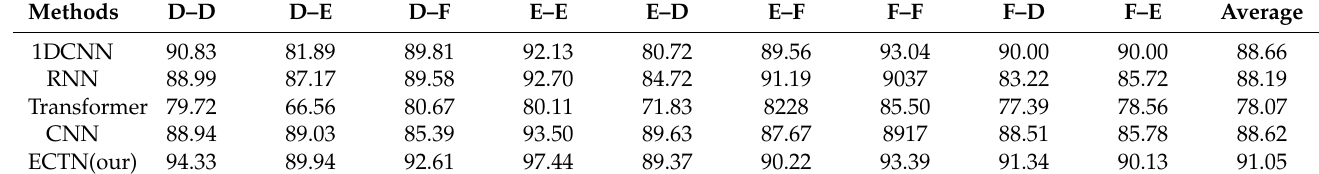
Table 10. Mean classification accuracy(%) with 1800 training samples on the Paderborn dataset.